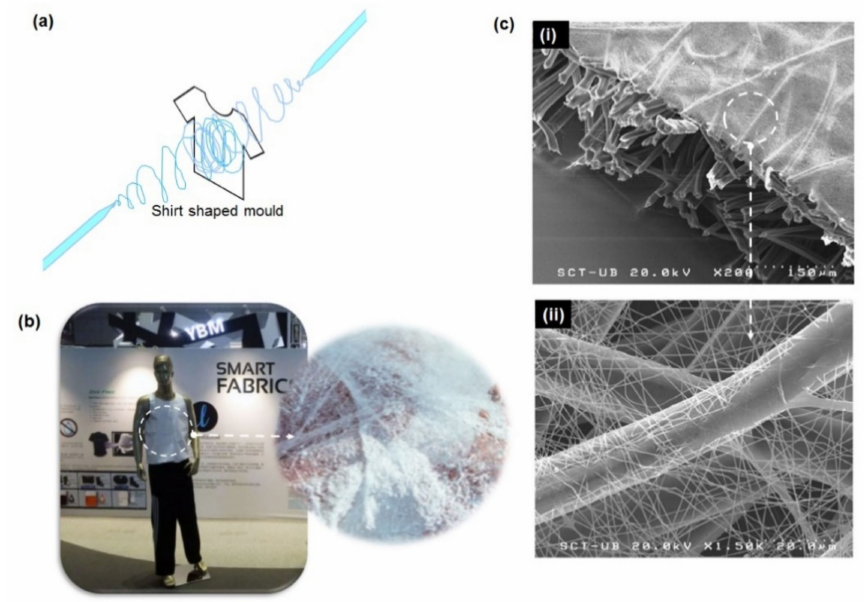
Figure 6. ( a ) Illustration of the molding technique for direct electrospinning. ( b ) The fabric from the Electroloom. ( c ) SEM micrographs of spunbonded polyamide (PA) 6 electrospun-viscose nonwoven membranes. Figures are adapted and modified from